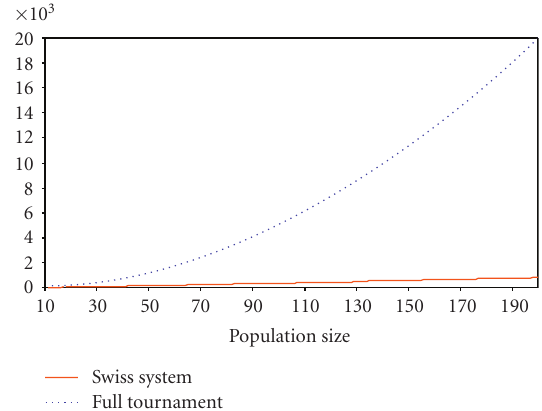
Figure 5: Total number of games in full tournament and Swiss